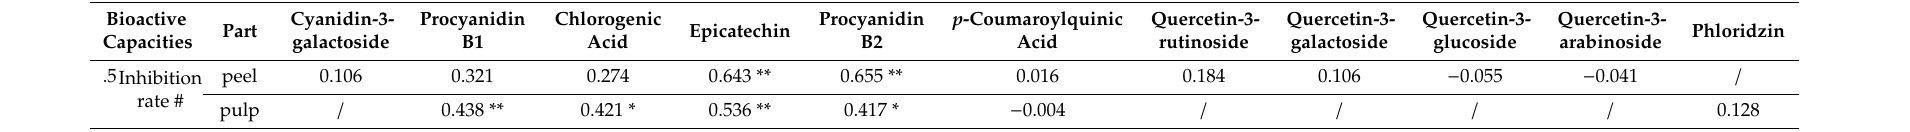
Table 6. Correlation analysis of phenolic components in apple SPE extract and HepG2 growth inhibition